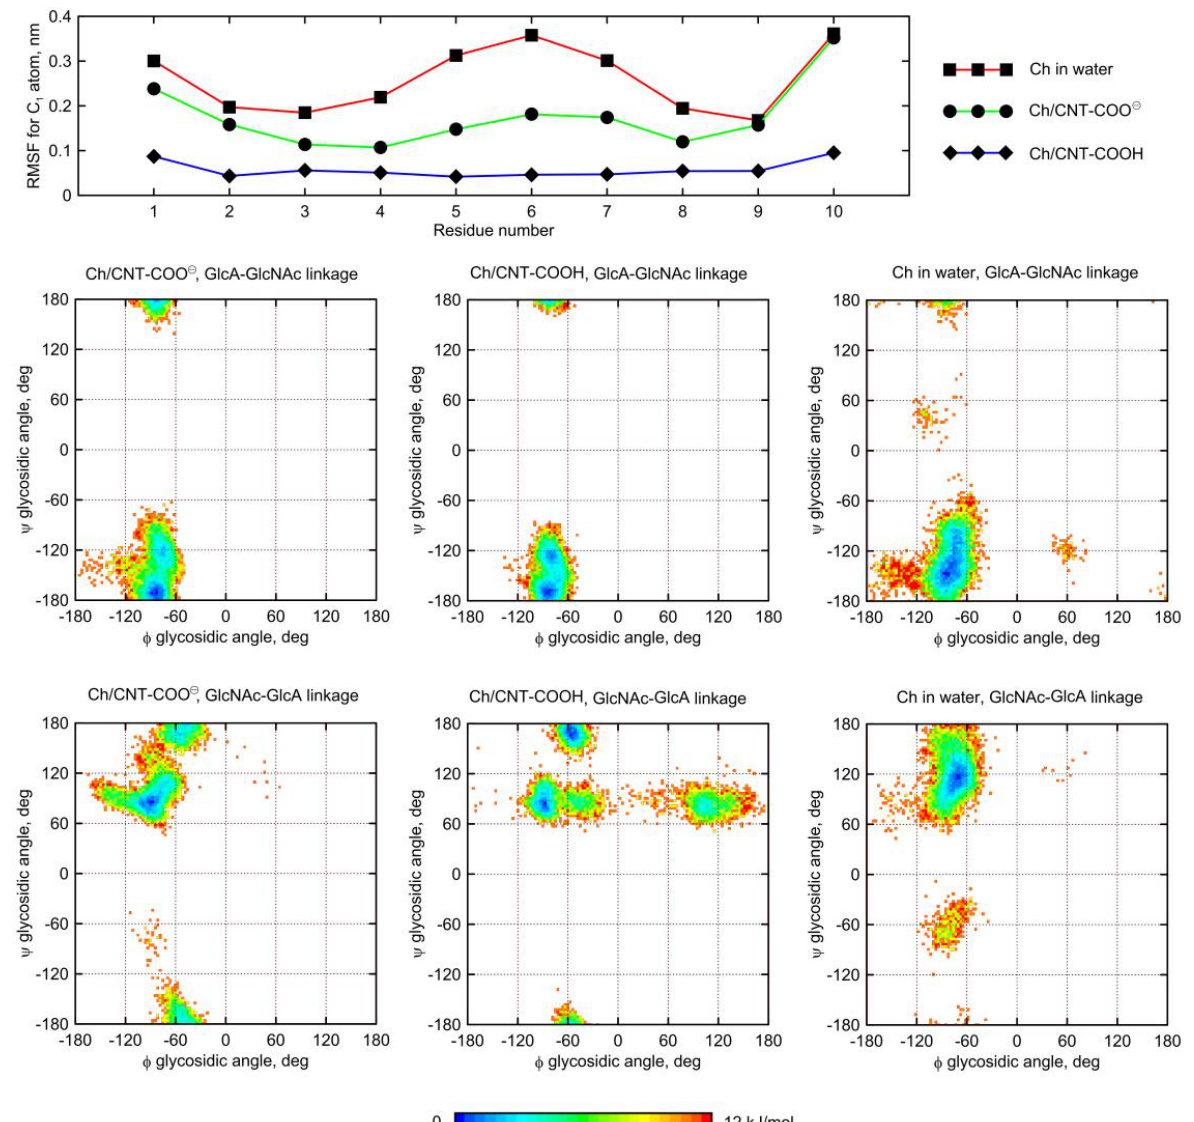
Figure 9. ( top ) Root-mean-square-fluctuation (RMSF) parameter values calculated for anomeric carbon atoms in the Ch decamer. ( bottom ) Free energy maps calculated from unbiased MD trajectories in the coordinates the glycosidic dihedral angle φ , ψ coordinates for the Ch molecule (details in Figure